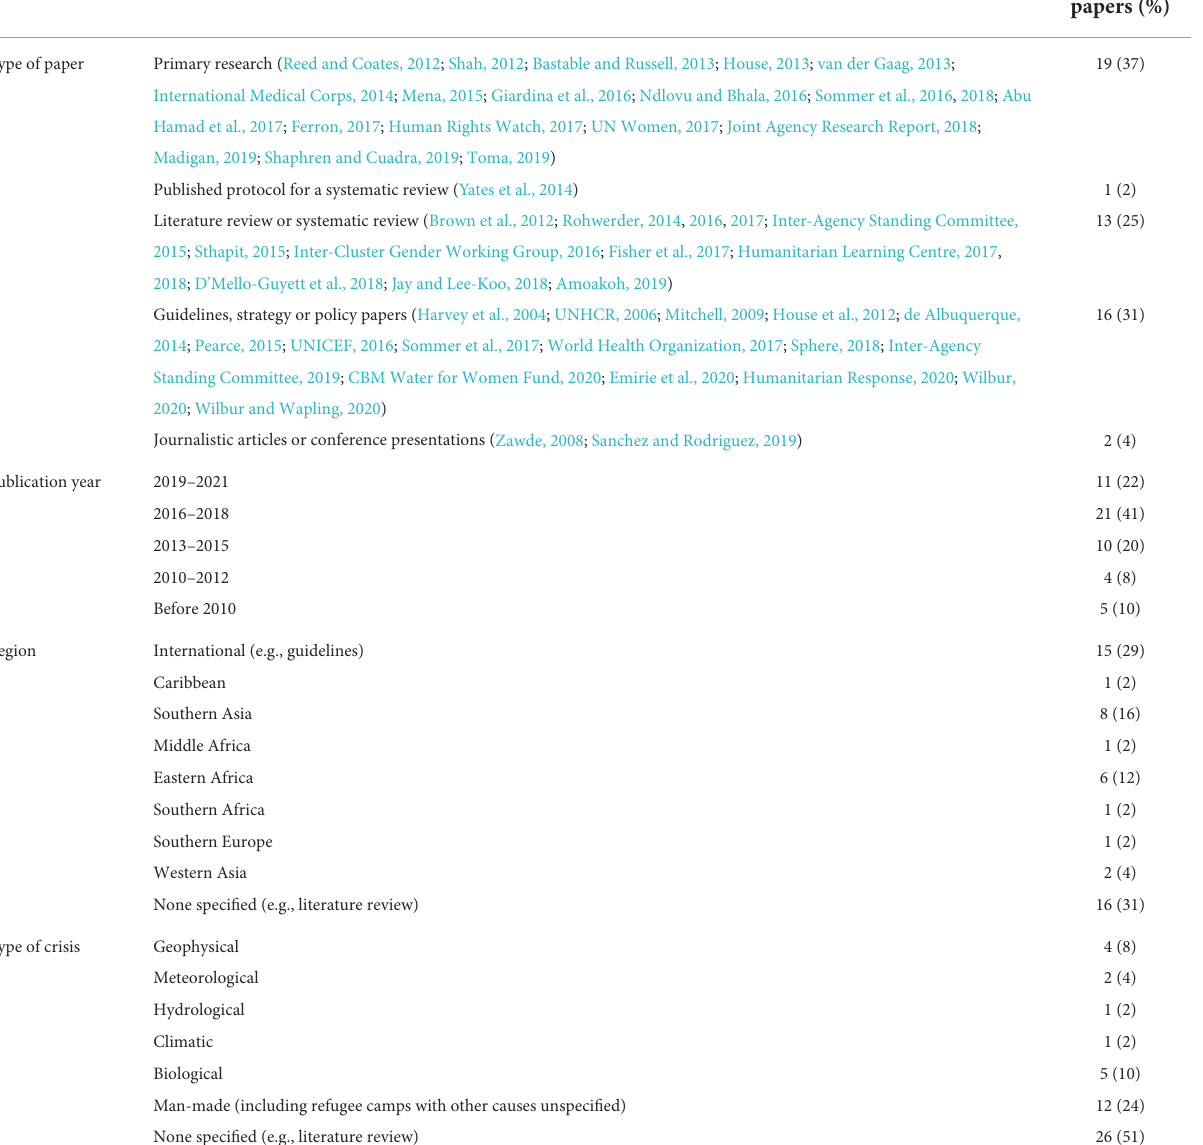
TABLE 2 Year of publication, region and type of crisis for the 51 included papers.